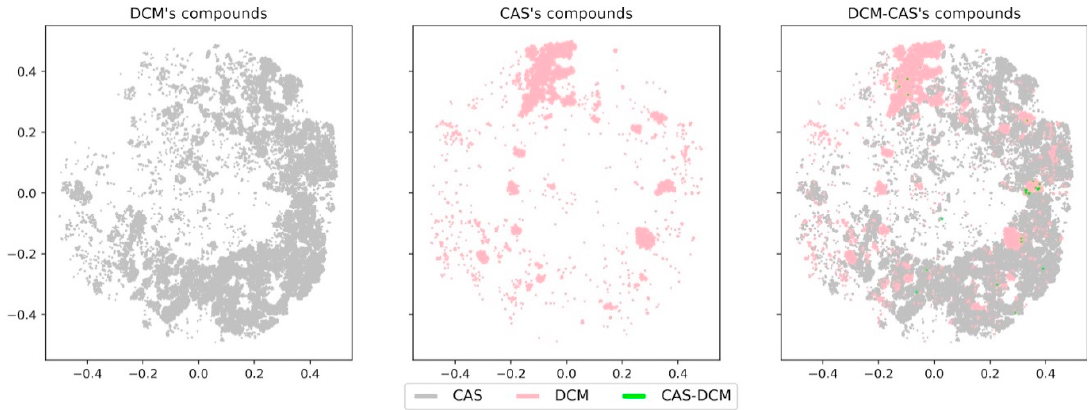
Figure 10. Visualization of the chemical space from CAS compounds (pink), DCM compounds (gray), and overlapping DCM-CAS compounds (green).